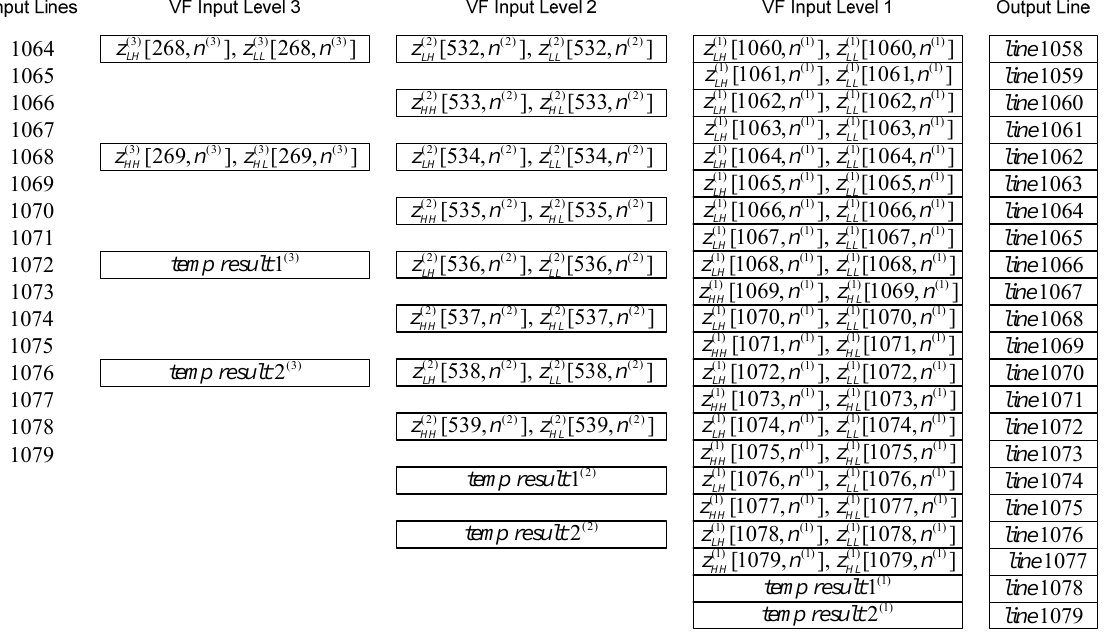
In order to ensure the proper inverse 2 ‐ D DWT 5/3 filtering of NN  image, two